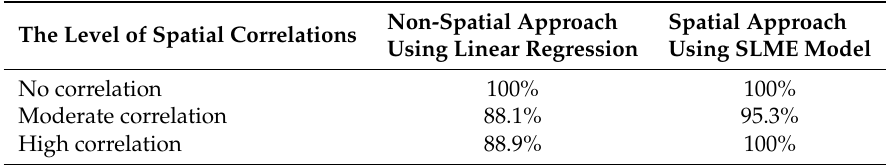
Table 10. Power of detecting the difference in shape between groups in spatial approach and non-spatial approach. The values in the table are the percentages of concluding the difference between disease groups in the Monte Carlo replications, if there is actually a difference, i.e., the power of the